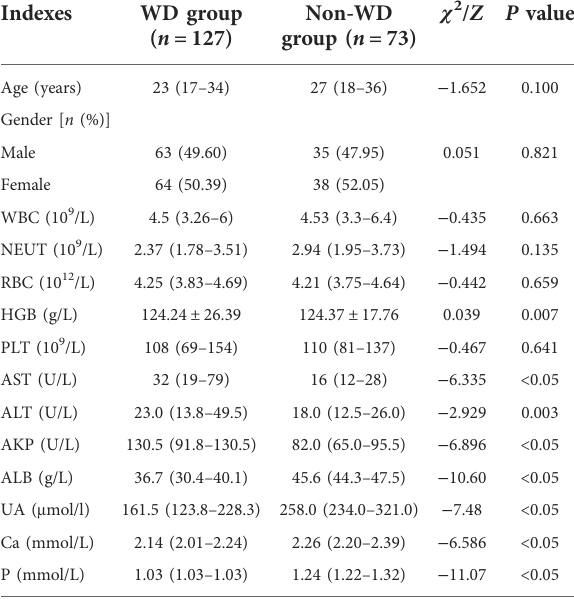
TABLE 2 Univariate analysis of clinical indexes in Wilson ’ s disease.